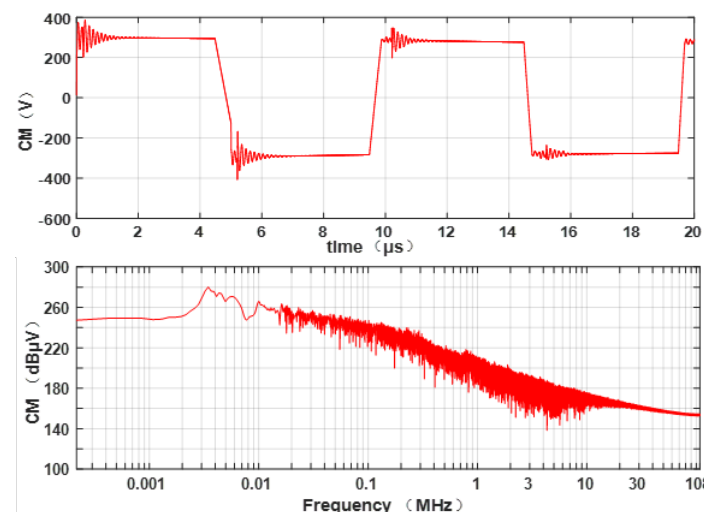
Figure 20. PWM signal of mosfet. Energies 2019 , 11 , x FOR PEER REVIEW